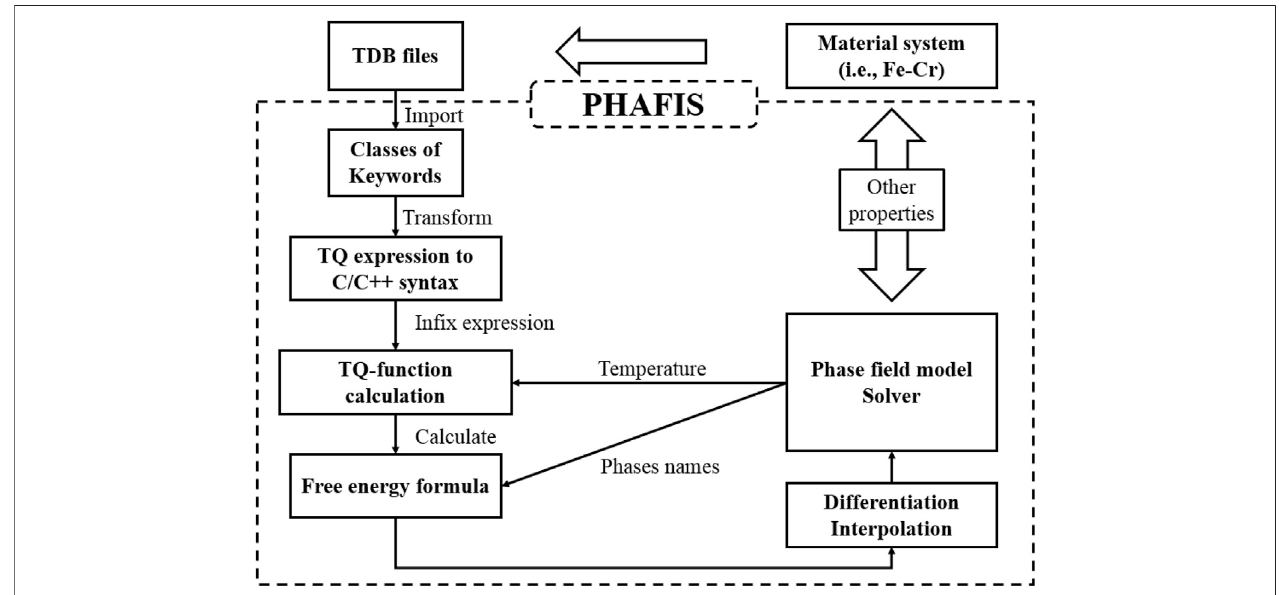
FIGURE 1 | TDB incorporation procedure. Once a TDB fi le of a material system is given, it will be parsed and converted into C/C++-compliant grammars. After solving the in fi x expression, the free energy expression at constant temperature can be obtained, which will be used by phase fi eld model solver by differentiation and interpolation.